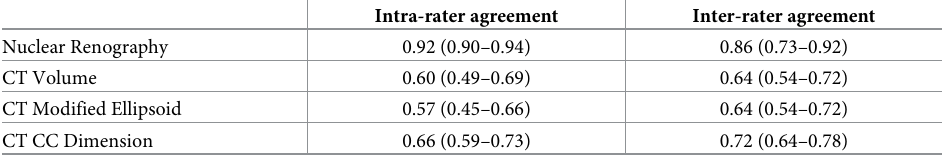
Table 4. Intra- and Inter-rater agreement for nuclear renography and CT based measurements assessed by intra- class correlation coefficient (ICC), n =